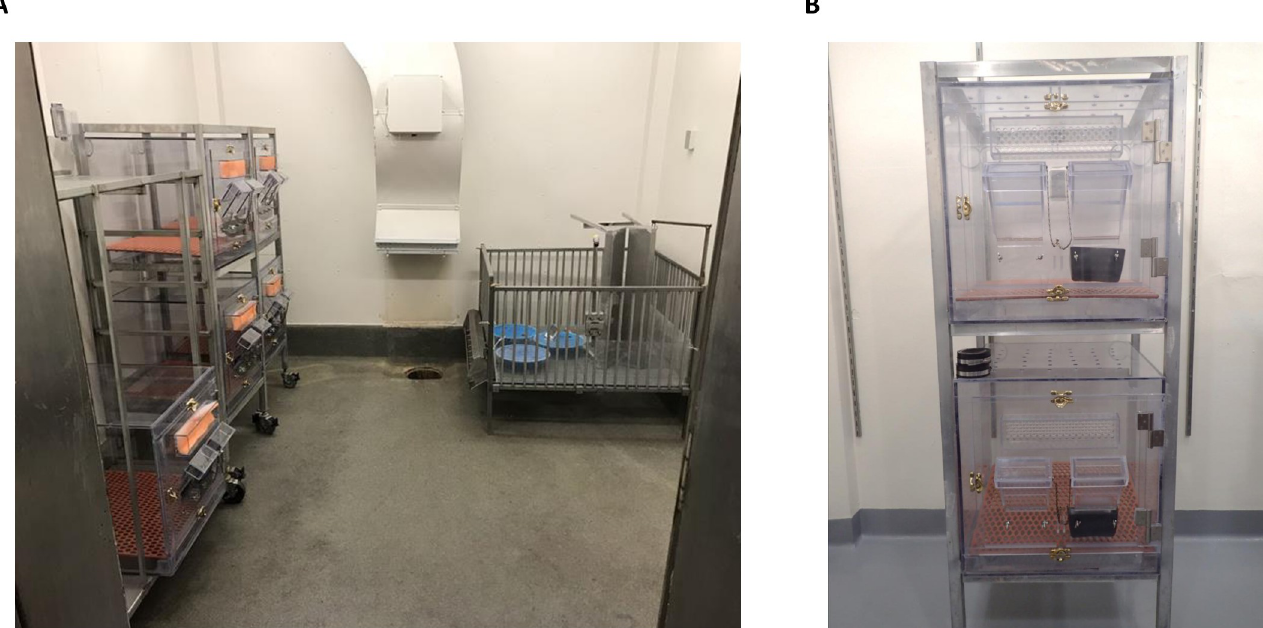
Fig 1. Housing for the neonatal pig infectious dose study. A) Room set up for each challenge dose. Five individual housing units with a raised deck for subsequent group housing. B) Each individual unit has a small port used for feeding and holes in the unit for air circulation were covered with filter paper.